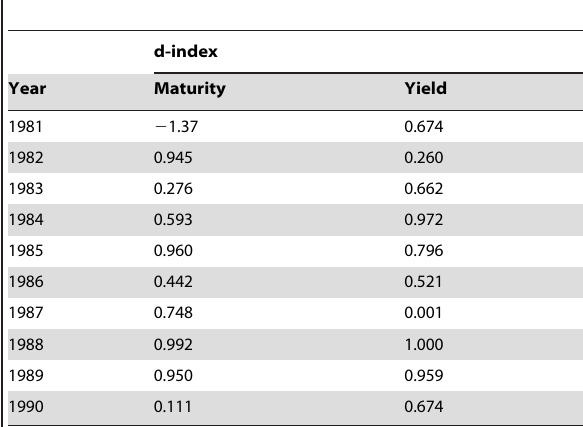
Table 3. Index of agreement ( d ) of maturity dates and grain